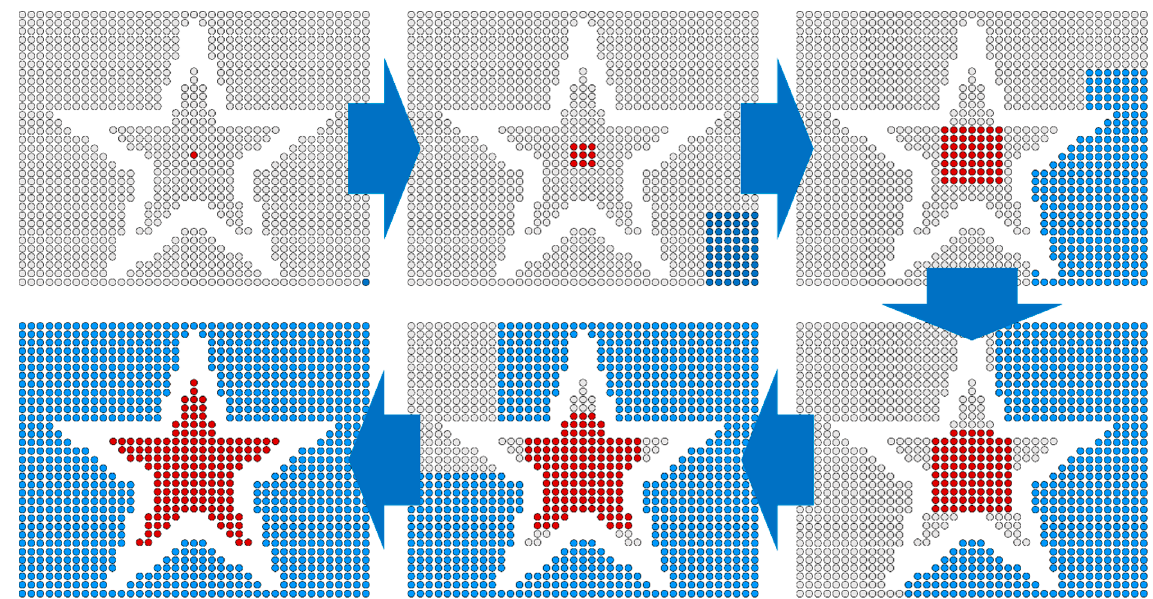
Figure 6. Region growing.